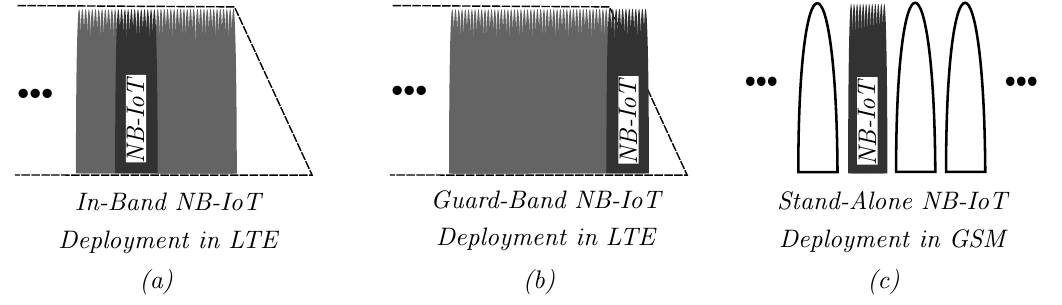
Figure 1. NB-IoT allows flexible deployment along existing mobile networks: ( a ) LTE in-band deployment, ( b ) LTE guard-band deployment, ( c ) GSM stand-alone deployment (adapted from